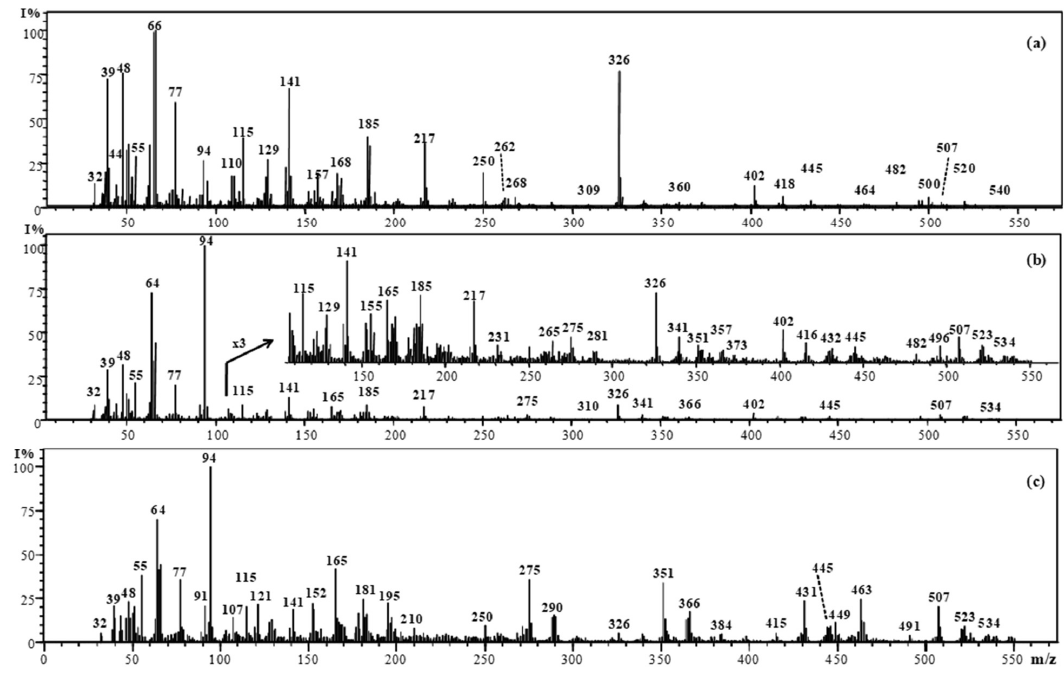
Figure 8. EI-DPMS spectra of the P(ESES)-co-(ESDPA) random copolymers ( a ) 70/30, ( b ) 50/50 and ( c ) 30/70 recorded in the temperature range 480–500 °C.